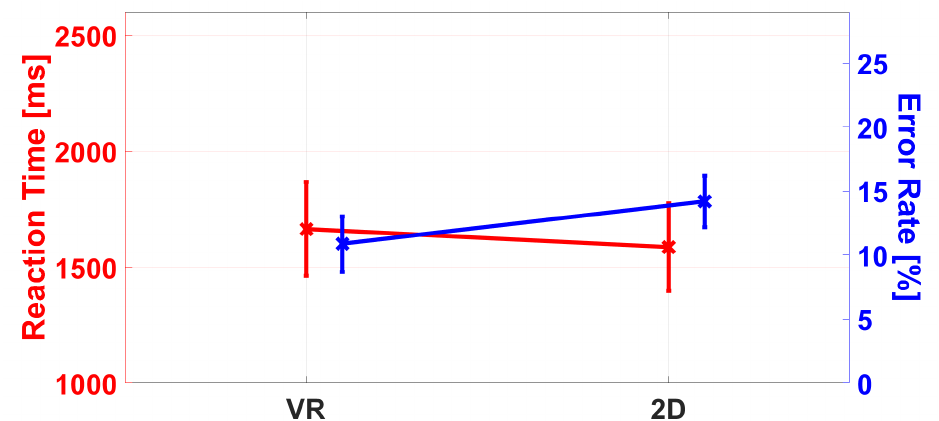
Figure 6. Differencein reaction times (RT, red in ms) and error rates (ER, blue in %) between the 2D and VR groups. In the reaction time, a trend toward lower RTs in the 2D group can be observed, which is not significant. The ANOVA revealed a significant effect in ERs, indicating higher ERs in the 2D group. The error bars represent the standard error.